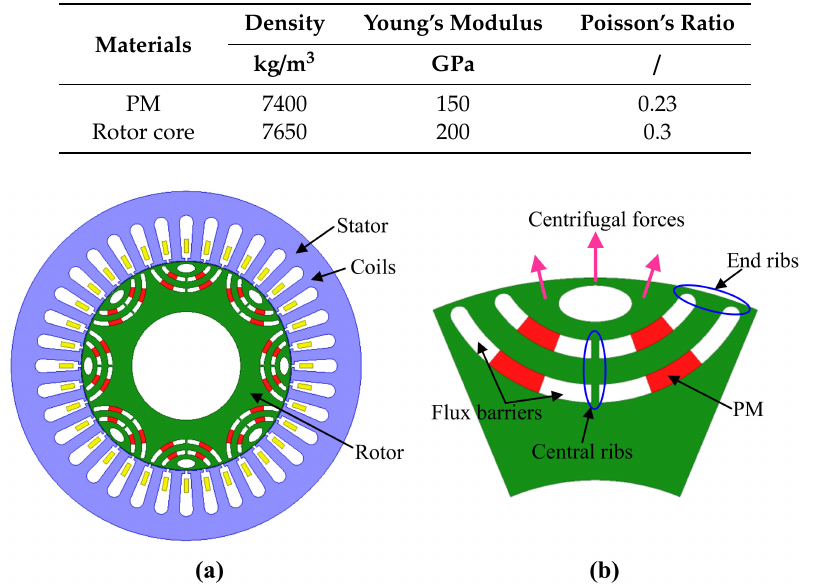
Figure 1. Machine and its rotor details: ( a ) the whole machine structure; ( b ) machine local structure and force characteristics.